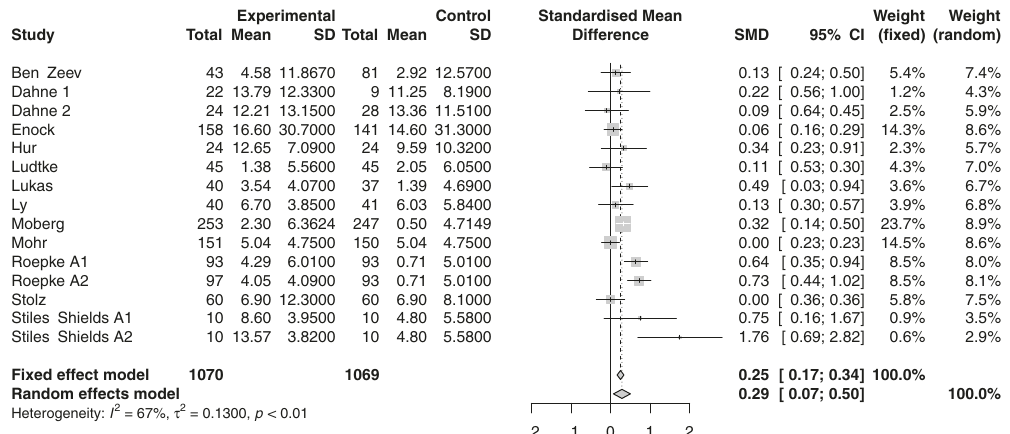
Fig. 3 Random effects meta-analysis in RCTs of app ef fi cacy comparing change in anxiety or depression symptoms in apps vs. control. Forest plot of random effects meta-analysis in RCTs of app ef fi cacy comparing change in anxiety or depression symptoms in apps vs. control.